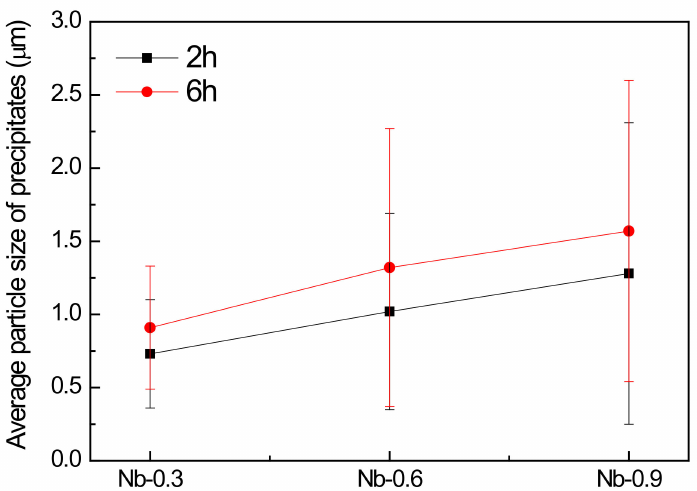
Figure 6. Average particle size of precipitates in the 22Cr25NiWCuCo(Nb) steel specimens with different Nb contents after heat treatment at 1200 °C for 2 and 6 h.